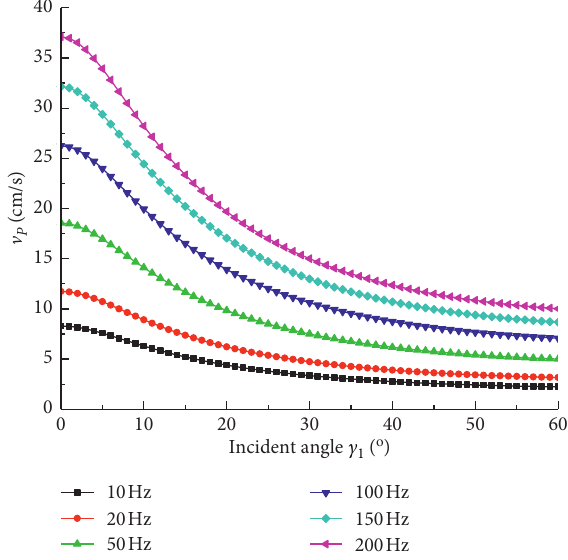
Figure 4: Variation of v